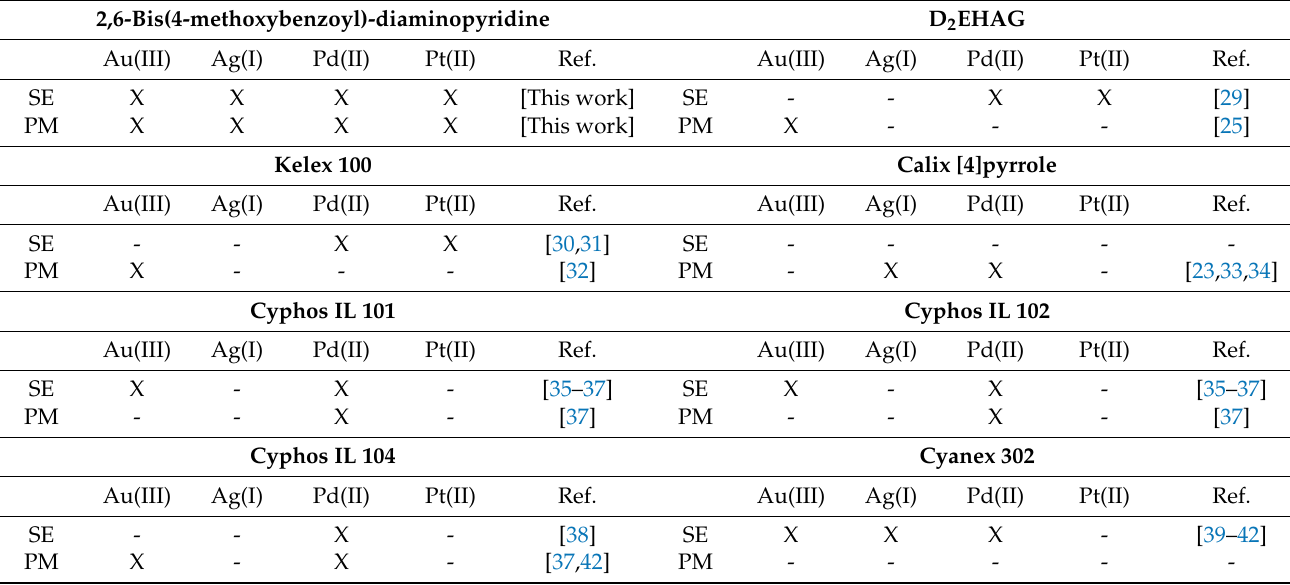
Table 3. Selected metal ion extractants/carriers used in separation processes (SE, PM) for the recovery of noble metal ions. 2,6-Bis(4-methoxybenzoyl)-diaminopyridine D 2